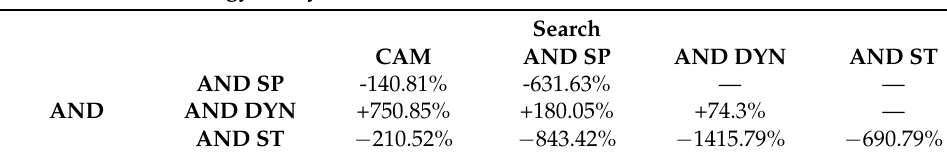
Table 11. Percentage differences in the AND and Search energy-delay products among the arrays. Each value corresponds to the increase, expressed in percentage, in the energy-delay product of the memory on the corresponding row with respect to the one of the memory on the corresponding column. The data are extracted from Table